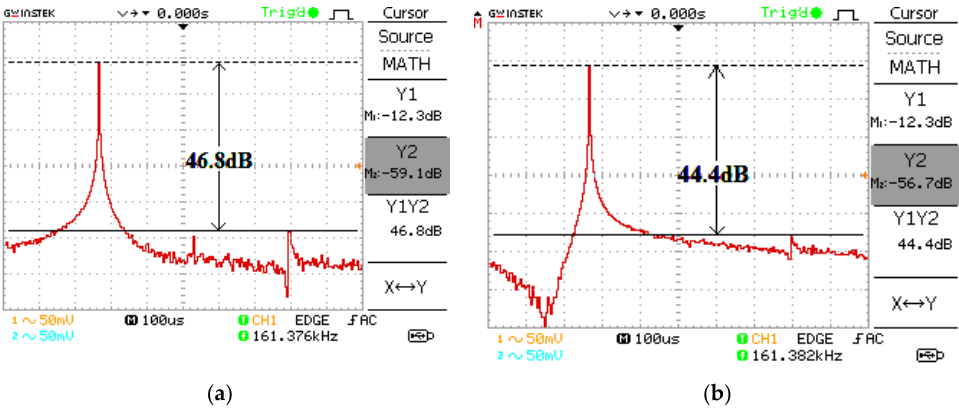
Figure 9. Measured spectrum for ( a ) v op1 and ( b ) v op2 .